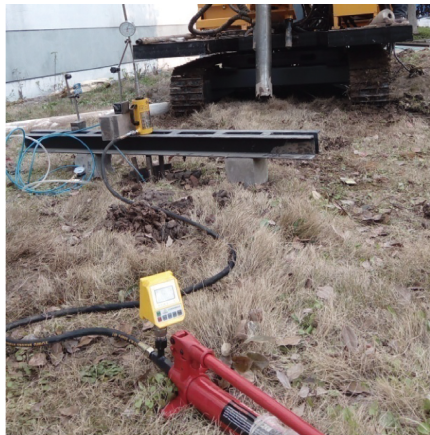
Figure 2: Photograph of the field